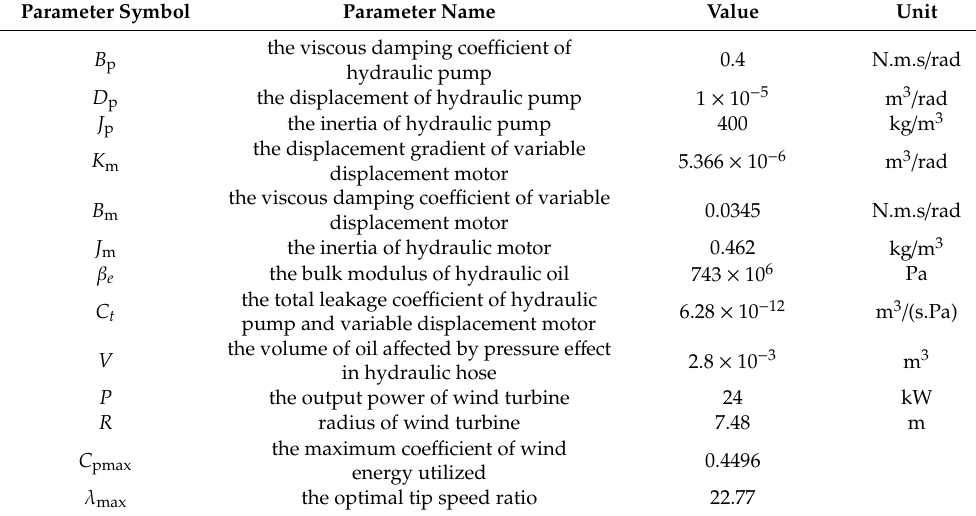
Figure 5. Simulation model. Table 2. Parameters of hydraulic drive system for experimental platform.